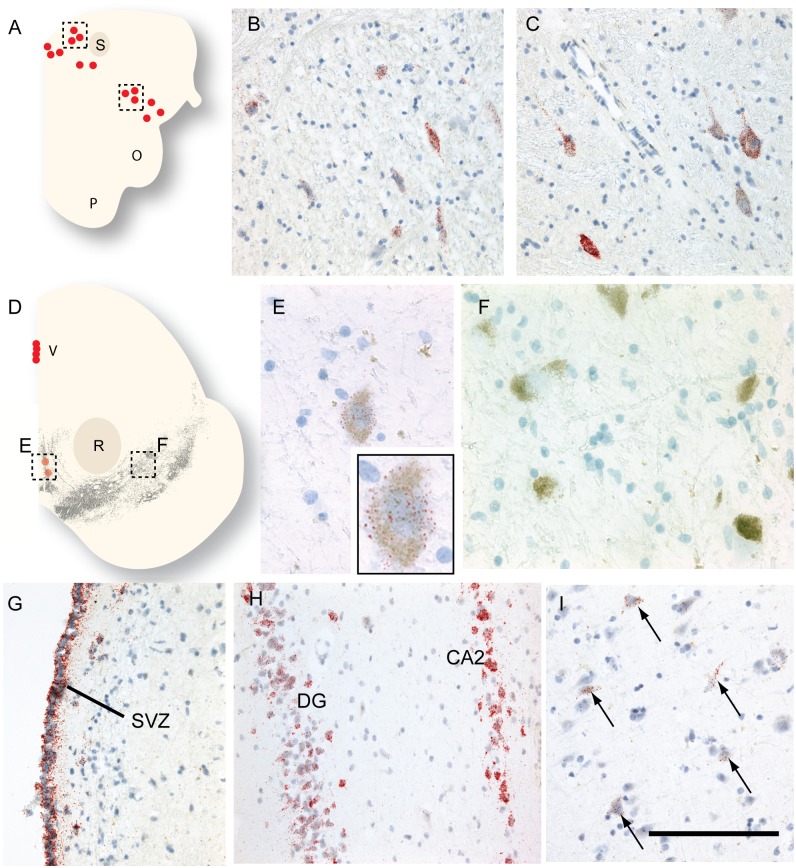
In situ hybridization of CD24 expression in the adult human brain.(A) A schematic of the medulla oblongata at the level of the pyramid (p), solitary nucleus (s), and the olivary nucleus (o). (B) CD24 transcripts in the dorsal motor nucleus of the vagal nerve. (C) Neurons expressing CD24 in the nucleus ambiguus. (D) A schematic of the midbrain at the level of the red nucleus (r) and the neuromelanin+ dopamine neurons (in grey). (E) An individual neuromelanin+ cell close to the midline weakly expressed CD24 (see inset for higher magnitude). (F) Neuromelanin+ cells in the SNpc, however, are void of CD24 labelling. (G) The lining of the subventricular zone (svz) at the level of the thalamus presented strong CD24 expression. (H) CD24 expression in the dentate gyrus (DG) and CA2 region of the hippocampus. (I) Weakly labelled CD24+ cell bodies in the amygdala. The scale bar in panel I represents 150μm in panels B and C, 100μm in panels E and F, and 250μm in panels G-I.